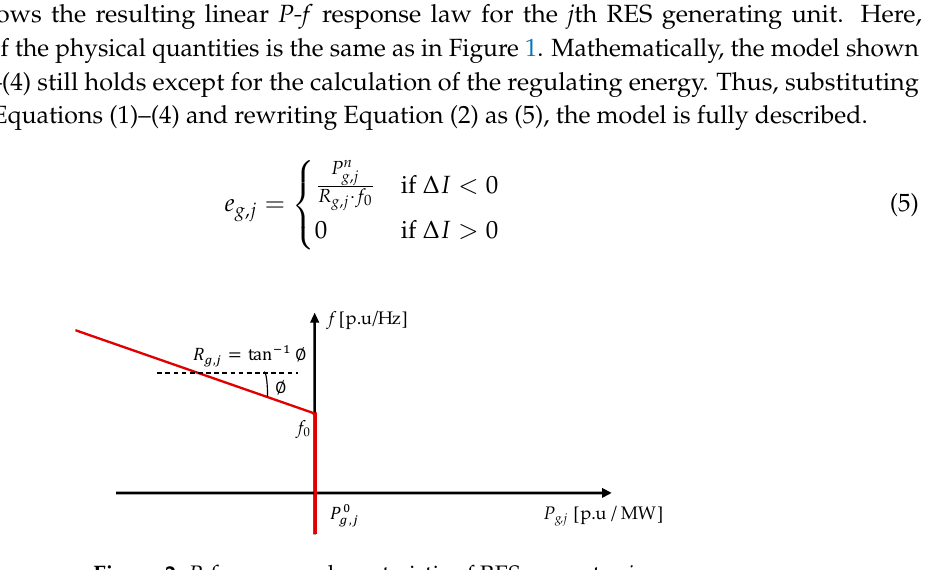
Figure 2. P-f response characteristic of RES generator j.